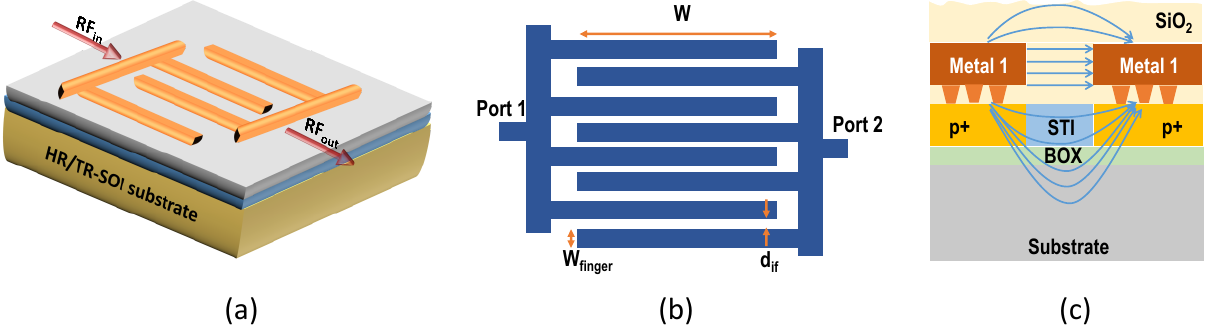
Figure 2. ( a ) Three-dimensional view of capacitive coupling structures showing interdigitated fingers; ( b ) top view; ( c ) cross-sectional view.